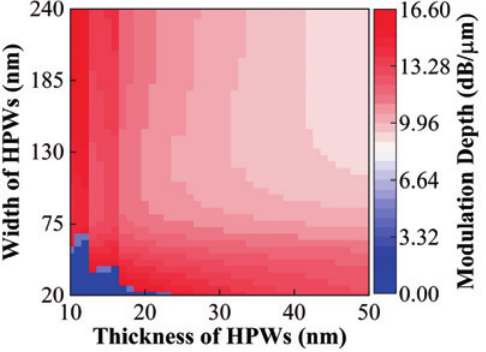
Figure 6: Shifts of modulation depth with the increase of t 1 and w .